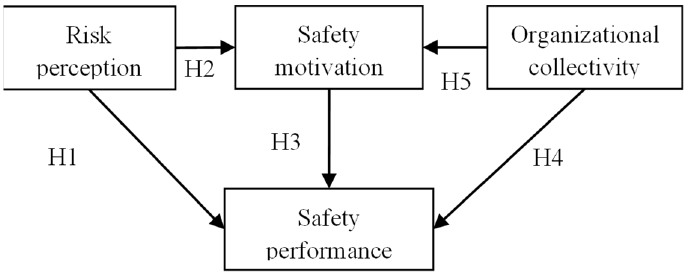
Figure 1. Integrated model of the influence on SP with hypothesized safety constructs.